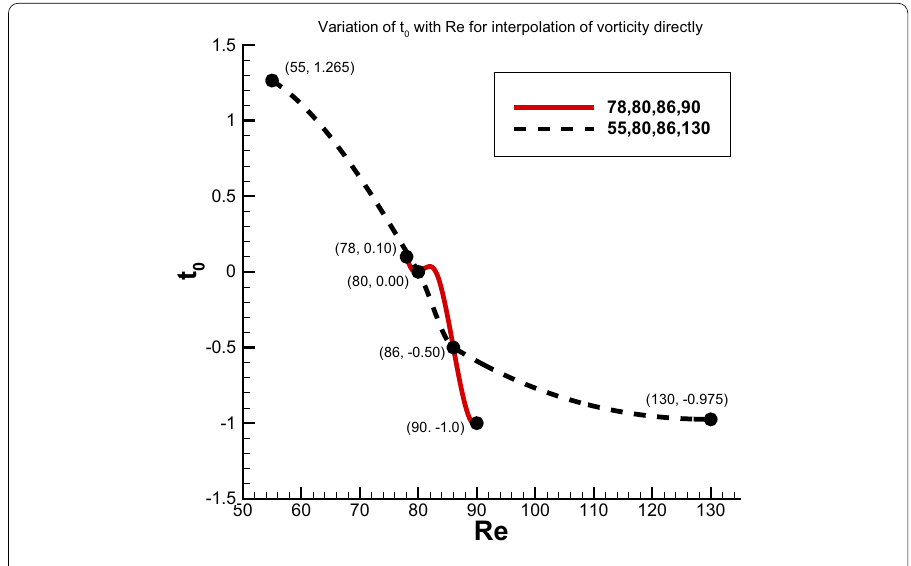
Fig. 10 Variation of t 0 with Re s for Re b = 80 for Case I (solid line) and Case V (dashed line) of Table 2. Shown in parametric form are the pair of Reynolds number and corresponding optimal t